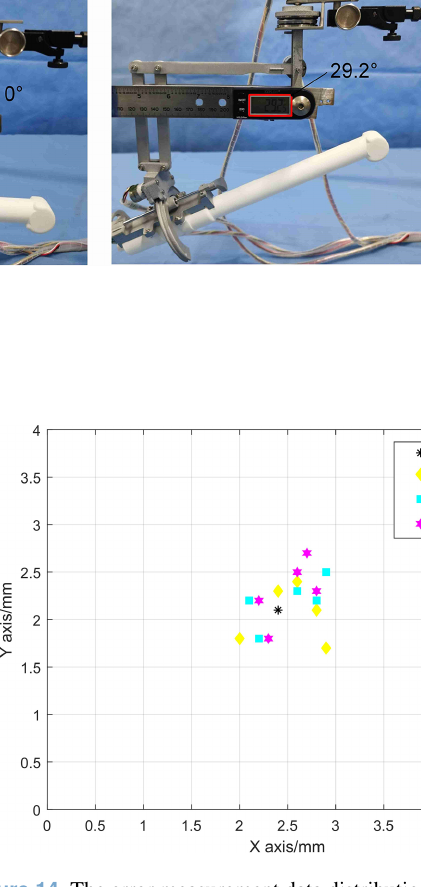
Figure 14. The error measurement data distribution diagram of the yaw angle’s remote center point.